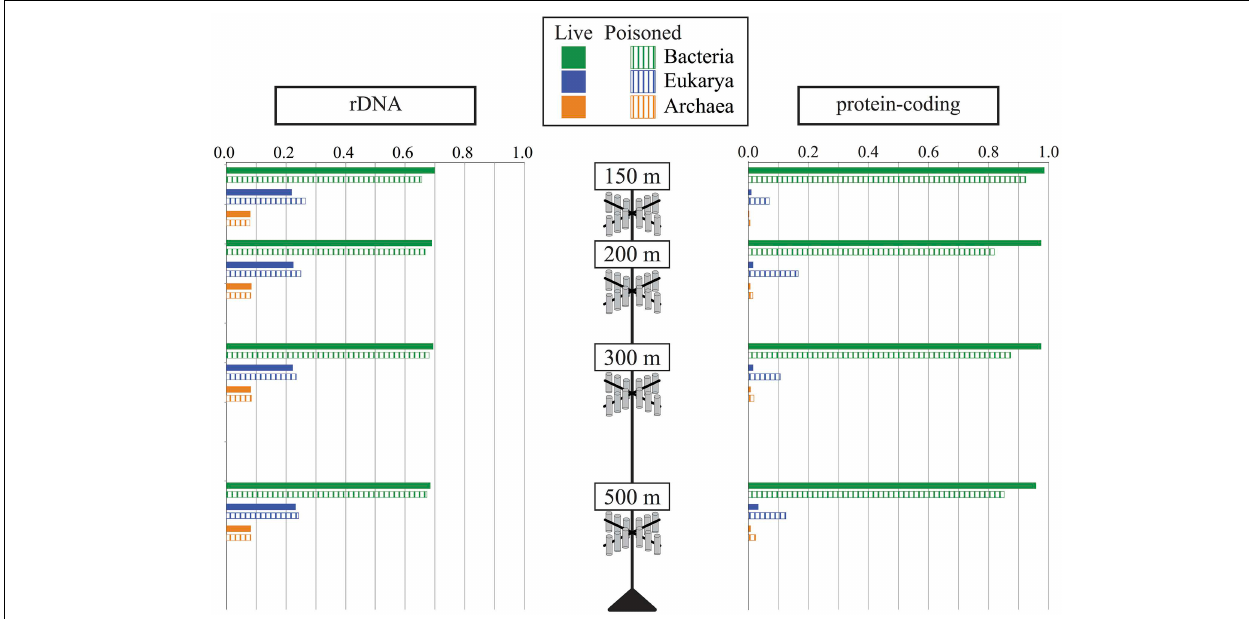
FIGURE 2 | The relative abundance of Archaea, Bacteria, and Eukarya in live (filled bars) and poisoned (striped bars) sediment traps at the indicated depths as determined by the taxonomic identifications of small subunit ribosomal RNA genes (rDNA) and protein coding genes.